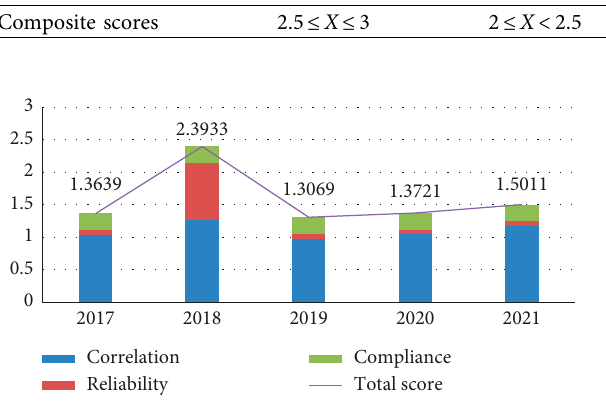
Figure 1: Comprehensive score of environmental accounting information quality. of Y Company from 2017 to